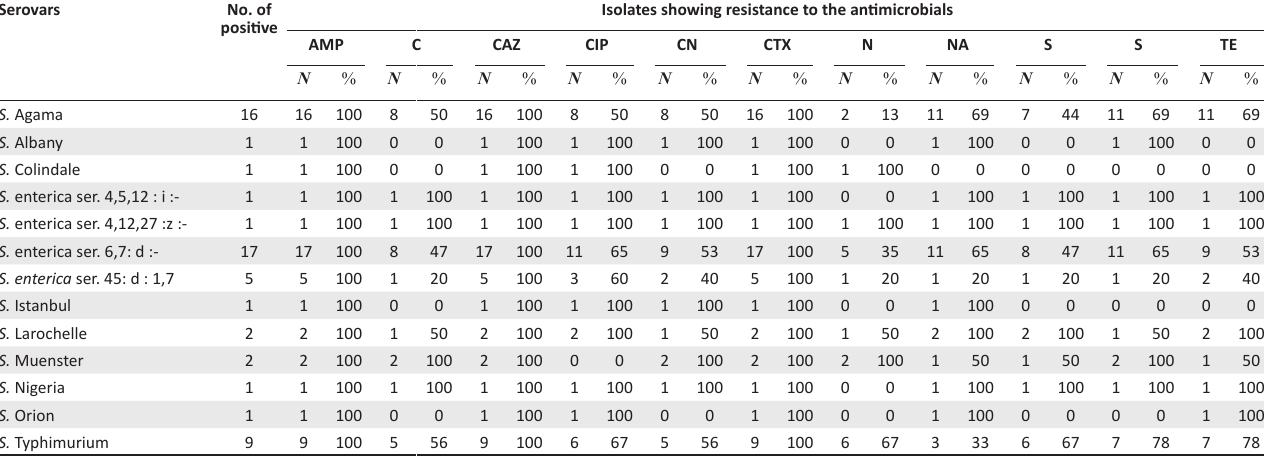
TABLE 5: Antimicrobial profiles of Salmonella serovars isolated from different poultry farms in Kwara State. Serovars No. of